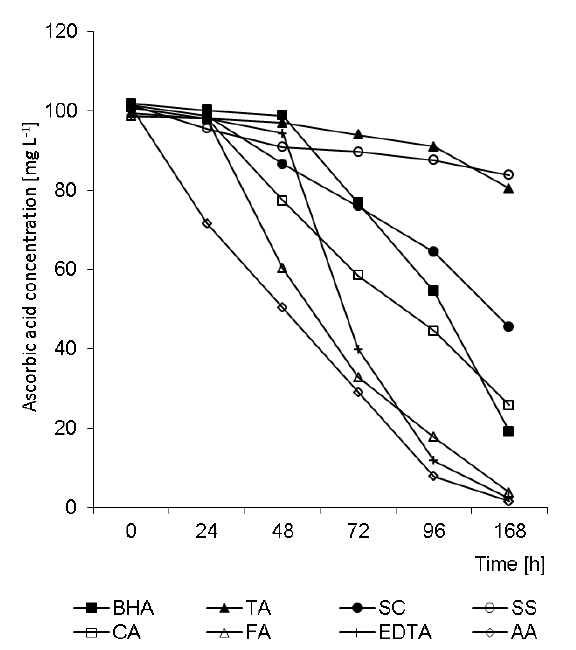
Figure 2: Changes in the concentration of ascorbic acid in a standard solution (100 mg L -1 ) with the addition of selected substances: buthylated hydroxyanisole (BHA), tartaric acid (TA), sodium citrate (SC), sodium sulphite (SS), caffeic acid (CA), disodium versenate (EDTA), formic acid (FA).